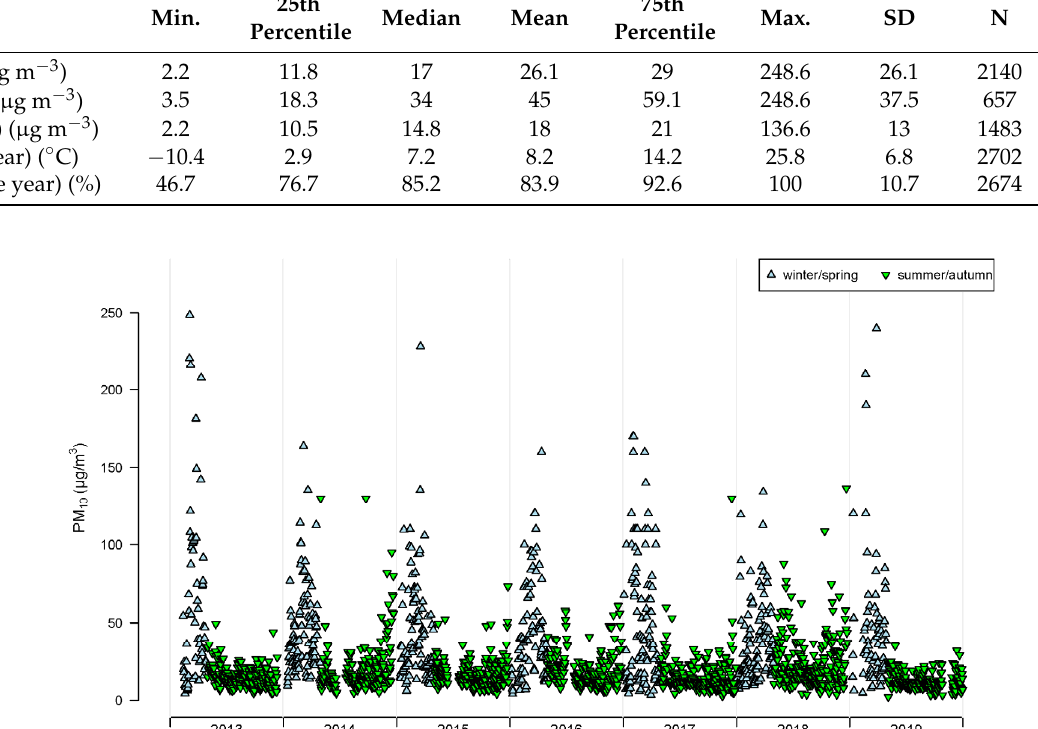
Table 2. Summary statistics (including standard deviation (SD) and number of observations (N)) of PM 10 ( µ g m − 3 ), temperature ( ◦ C), and relative humidity (%) in Visby during the period of 2013–2019. Min.